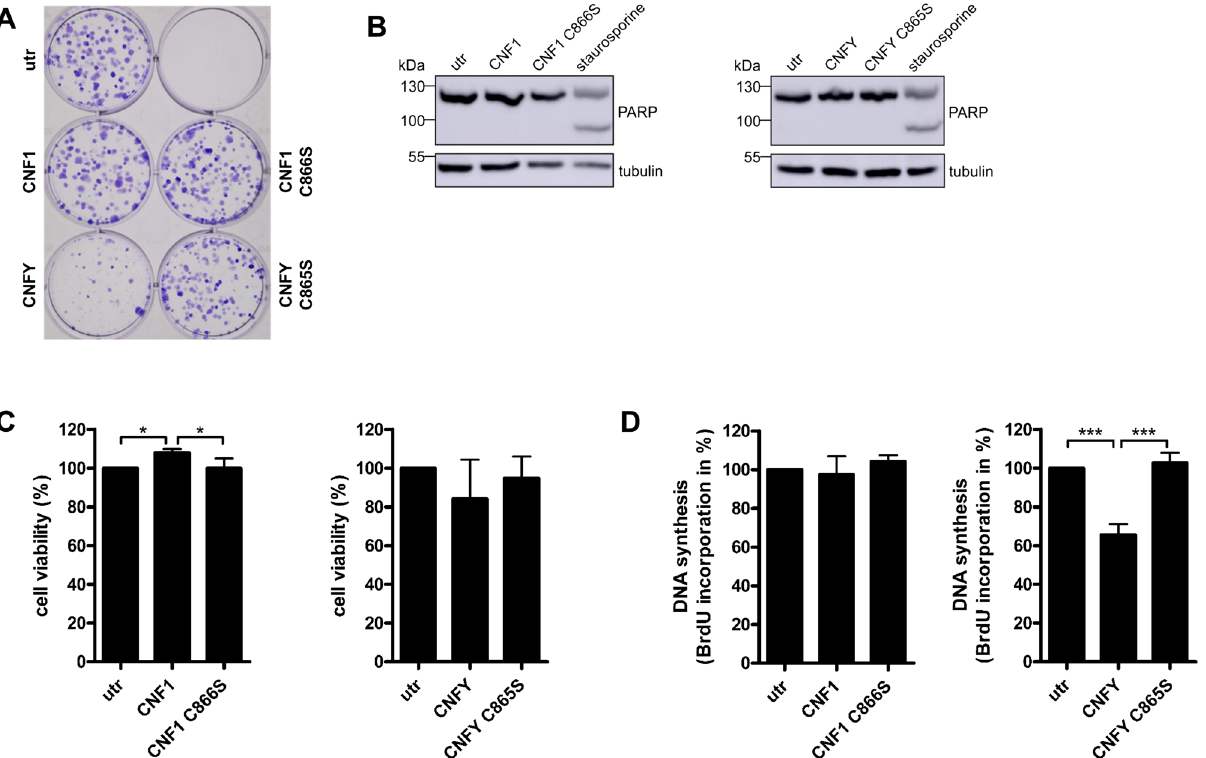
Figure 2. Intoxication with CNFY inhibits proliferation of MCF10A cells. ( A ) MCF10A wild-type cells were treated for 6 days with CNF1 or CNFY. The inactive toxin mutants served as a negative control. Cell colonies were stained with crystal violet (representative of n = 3). ( B ) Detection of PARP cleavage after intoxication with CNF1 or CNFY for 48 h. Treatment of the cells with 1 µM staurosporine for 16 h was used as a positive control, CNF1 C866S and CNFY C865S as negative controls, respectively. Representative Western Blots of three independent experiments are shown. Tubulin served as a loading control. ( C ) Cell viability of MCF10A wild- type cells was measured after CNF intoxication for 48 h. Metabolic activity was normalized to the untreated cells. Data of three independent experiments were quantified and analyzed using one-way ANOVA. ( D ) BrdU ***p <